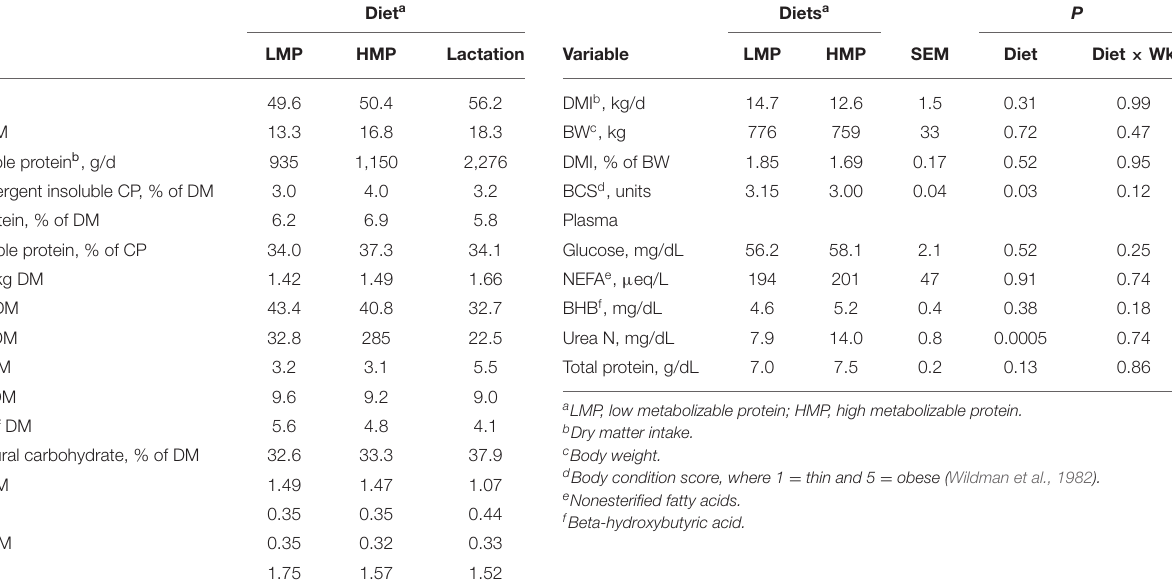
TABLE 3 | Prepartum variables for cows consuming low (L) or high (H) amounts of metabolizable protein (MP) prepartum. Diets a